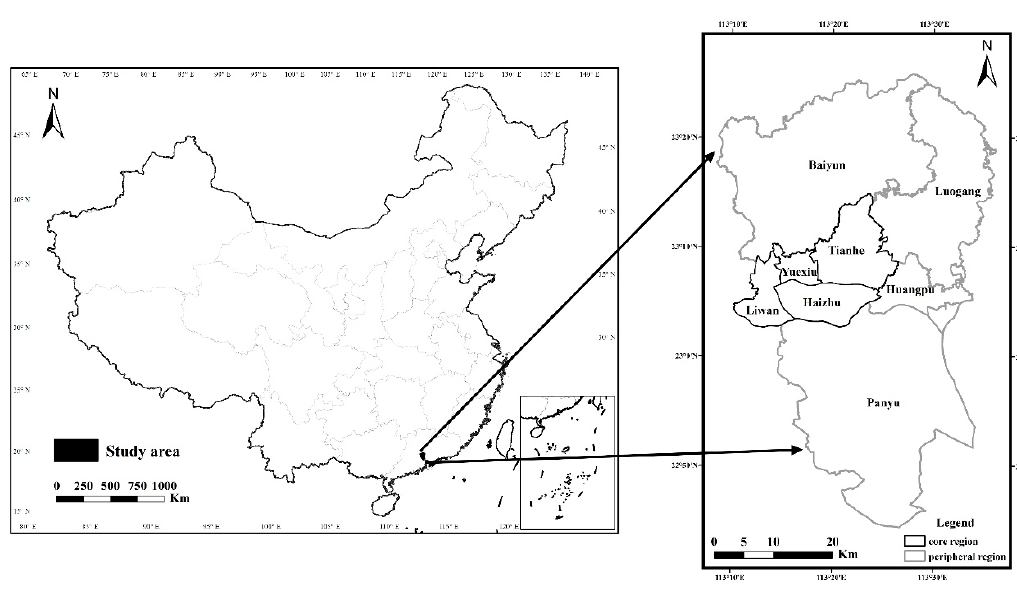
Figure 1. Study area and its location in China.